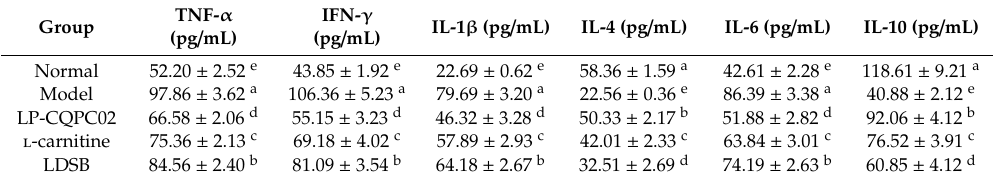
Table 7. Cytokine levels of tumor necrosis factor alpha (TNF- α ), interferon gamma (IFN- γ ), interleukin 1 beta (IL-1 β ), interleukin 4 (IL-4), interleukin 6 (IL-6) and interleukin 10 (IL-10) in serum of mouse ( n = 10). TNF- α Group (pg /